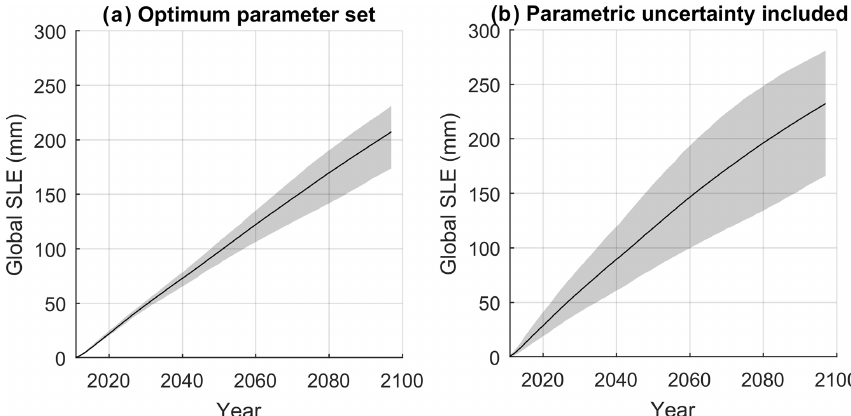
Figure 16. Multi-model mean (black line) and ensemble spread (shaded) global volume loss in sea level equivalent. Panel (a) shows the volume loss when optimum parameter sets are selected by minimising the RMSE and (b) is volume loss when optimum parameter sets are selected using additional performance metrics (minimising RMSE, minimising the bias, and maximising the correlation coefficient).